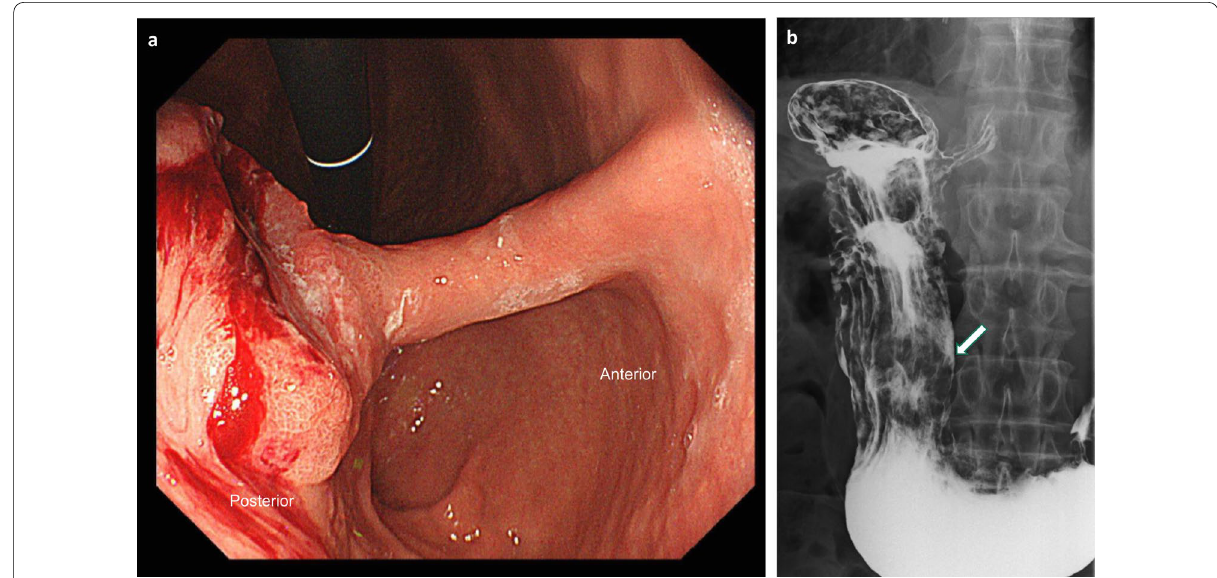
Fig. 1 Preoperative imaging. a Gastrointestinal endoscopy findings. A type 2 tumor was found on the posterior wall of the middle gastric body. b Double-contrast barium imaging. An elevated tumor with ulcerative lesions of 4 cm diameter was detected in the posterior wall of the middle gastric body (arrow)